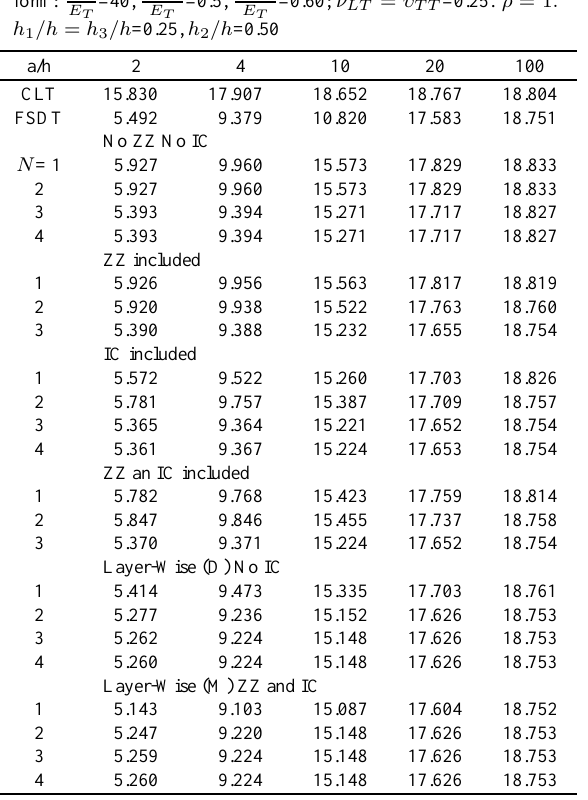
Table 4 (cid:1) Multilayered cross ply plate 0 / 90 / 0 . Circular frequency parame- a 4 ρ/E T h 2 . Data of the layers in non ter ¯ ω = ω